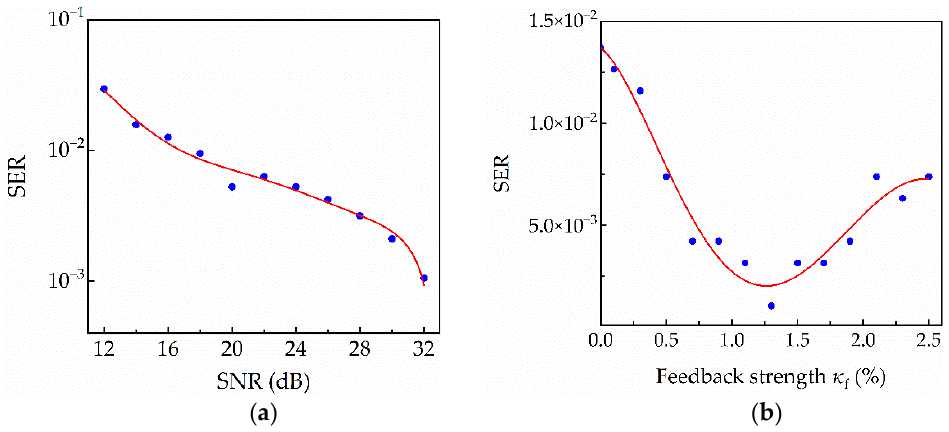
Figure 9. ( a ) The SER as a function of SNR; ( b ) The SER as a function of feedback strength κ f ; with I = 12 I th , κ inj = 0.8, Δ ν = −2 5 GHz and M = 50.